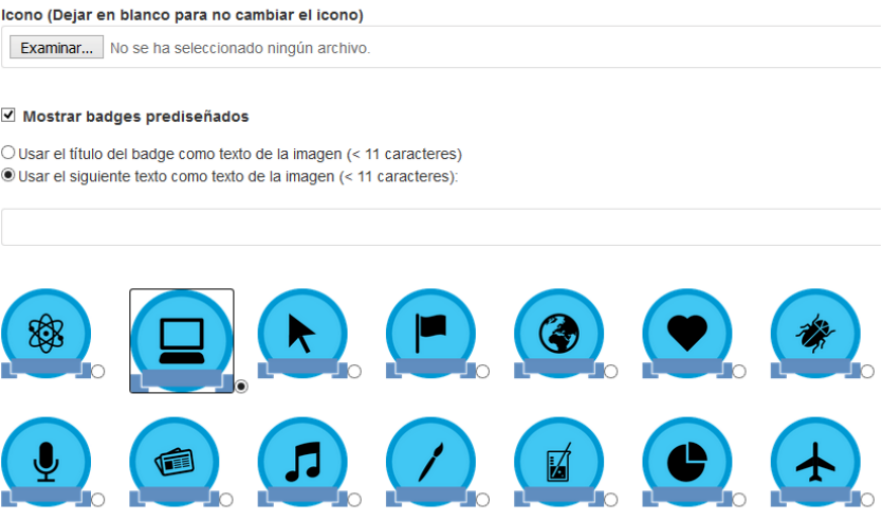
Figure 1. Selection of the icon of the